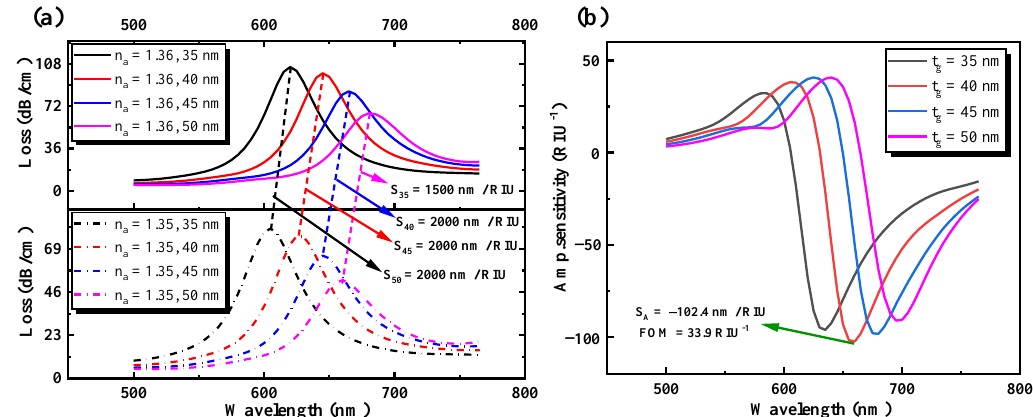
0.3 Ʌ Figure 4. Influence of PCF structure parameters on the loss spectrum curve. ( a ) Air holes pitch, Λ ; ( b ) Air holes diameter, d 1 ; ( c ) Resonance wavelength varies with the diameter, d 1 ; ( d ) d 1 = 0.2 Λ optical field distribution. 3.3. Discussion on the Varying Thicknesses of the Gold Layer Figure 5 illustrates the effect of the confinement loss and the sensitivity of amplitude on the efficiency of sensing with a difference in the thickness of the gold layer without graphene. In Figure 5a, the loss peaks decreased from 79.9 to 52.3 dB/cm for n a of 1.35 and from 105.48 to 65.9 dB/cm for n a of 1.36 with the increase in gold layer thickness from 35 to 50 nm. It can be seen that with a change in gold layer thickness from 35 to 50 nm, the loss peaks progressively downward; the thicker the gold layer, the greater is the loss of damping. Increasing the gold layer thickness would cause the peak loss to change towards a longer wavelength (red shift). The definition of the red or blue shift (move-